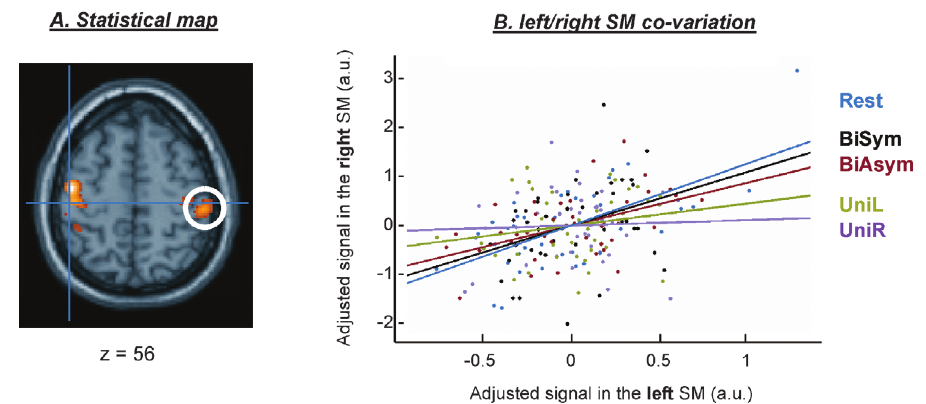
Figure 4. Example of connectivity results for a single subject. Results of the connectivity analyses seeded in the left SM-region. Panel A shows a projection of the F-map on a transverse anatomical section, revealing a covariation between the signal in the left SM-region (blue cross) and the homologous SM-region in the right hemisphere (white circle). Panel B illustrates the coupling between the two regions, as a function of